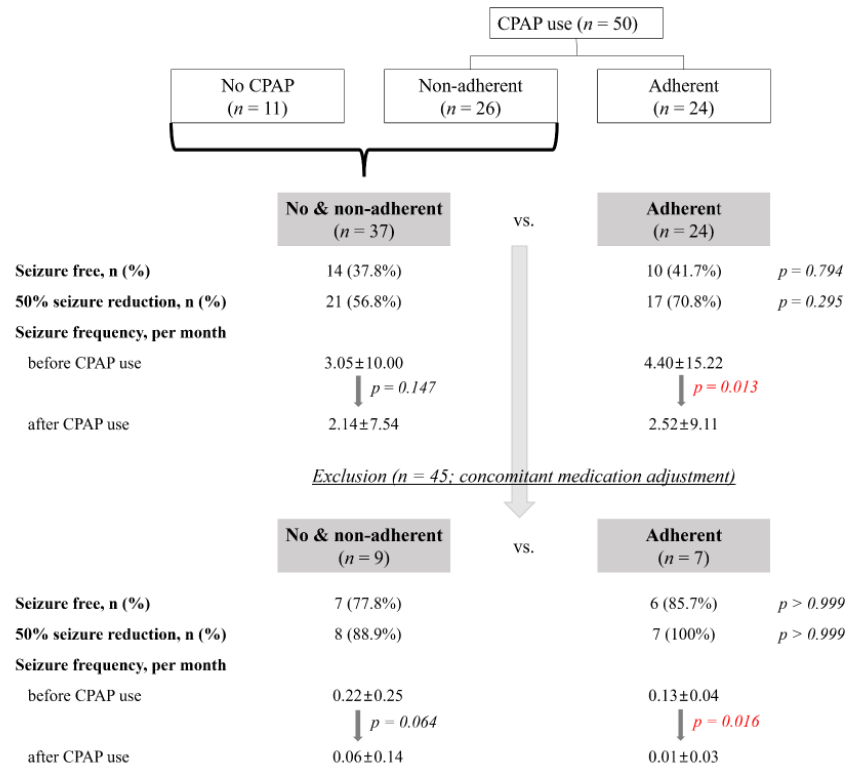
Figure 2. Flow diagram illustrating the use of continuous positive pressure (CPAP)